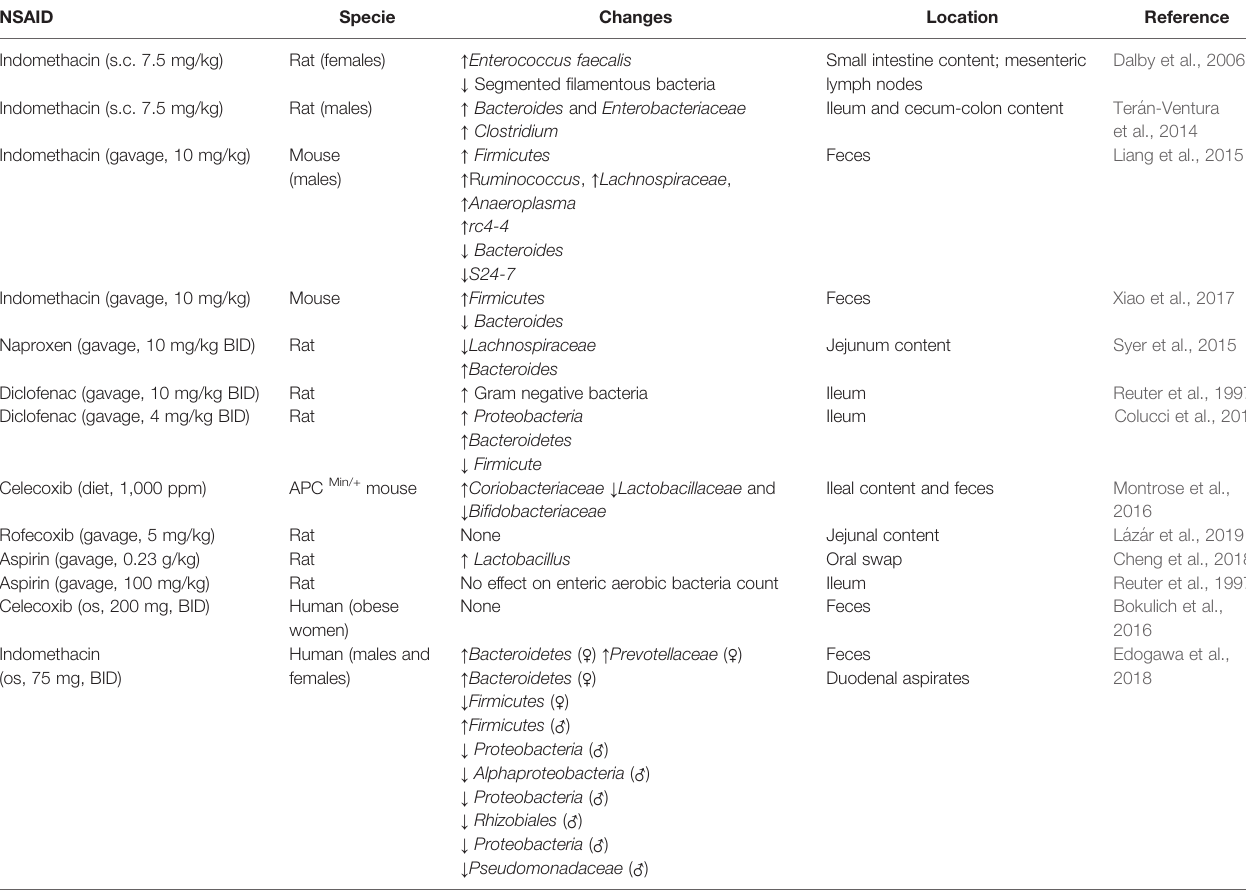
TABLE 2 | Studies assessing the perturbation of the gut microbiota composition by